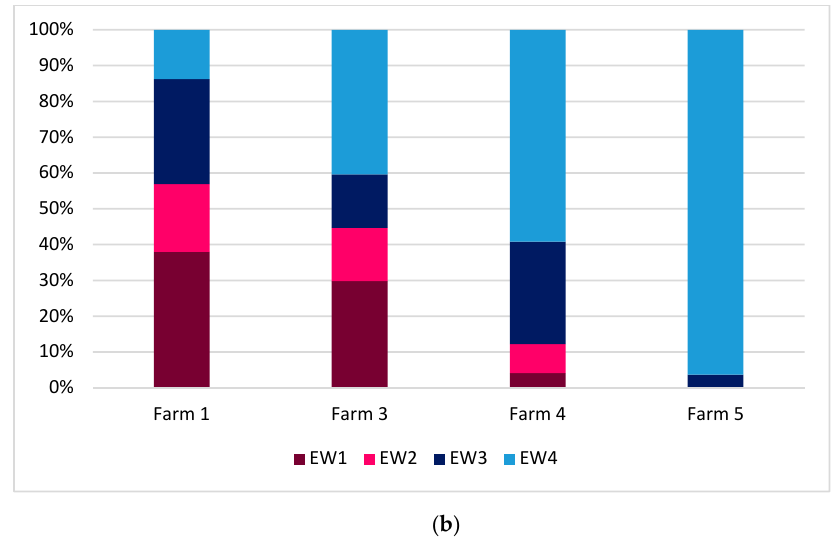
Figure 6. Results of the eye white in the farms included in the study. ( a ) during feeding; and, ( b ) during resting.